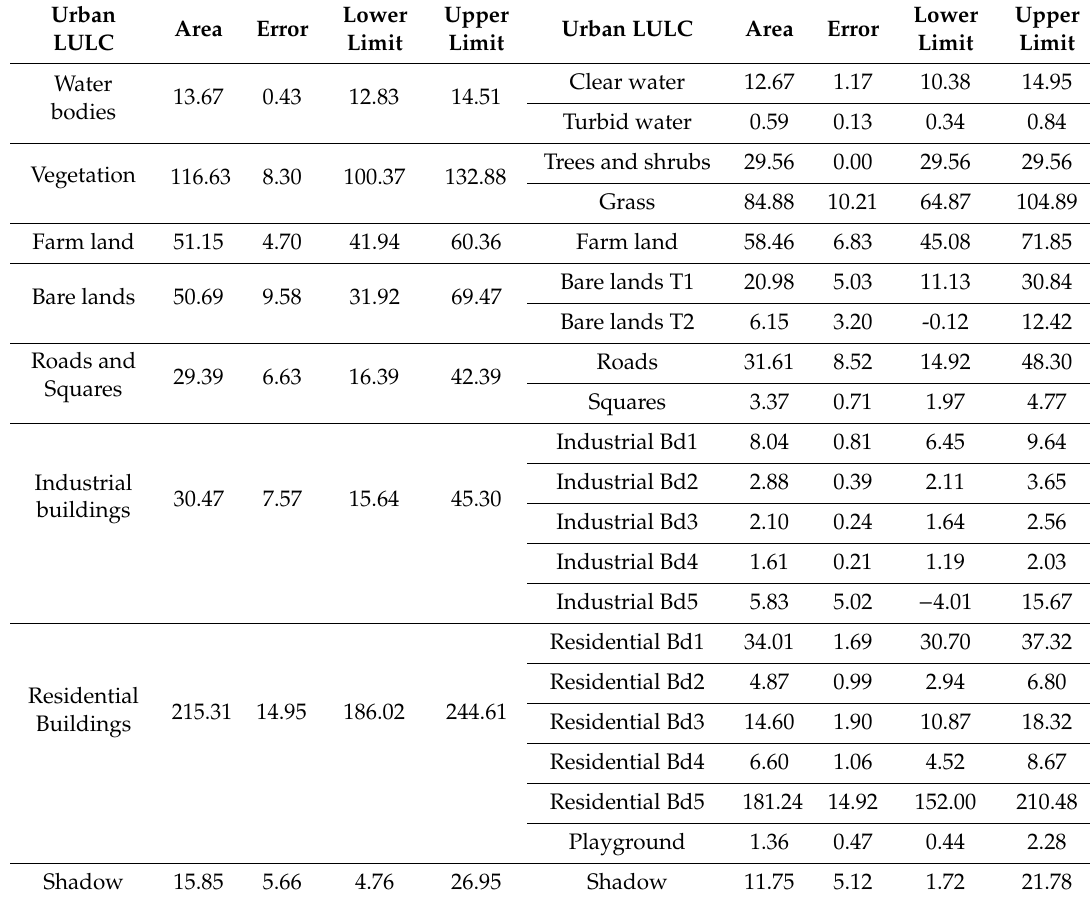
Table 8. The estimated area (km 2 ) of each class with a 95%